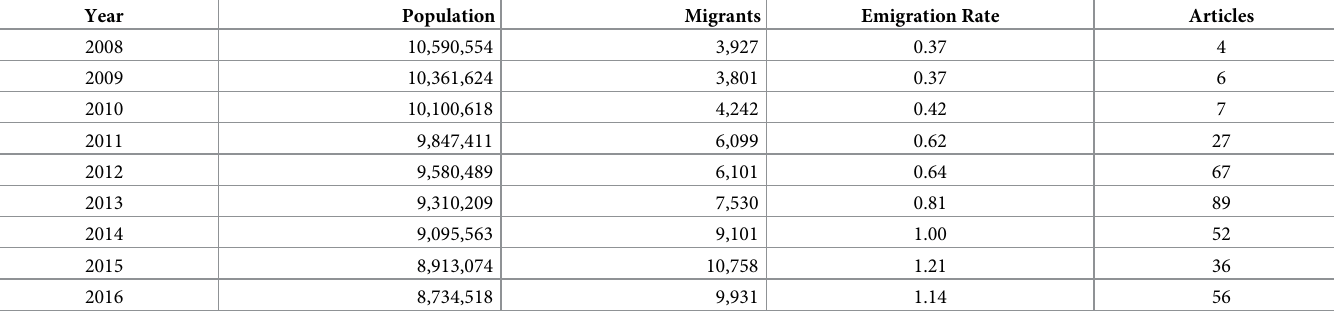
Table 5. Correlation between the emigration rate and number of articles. Year